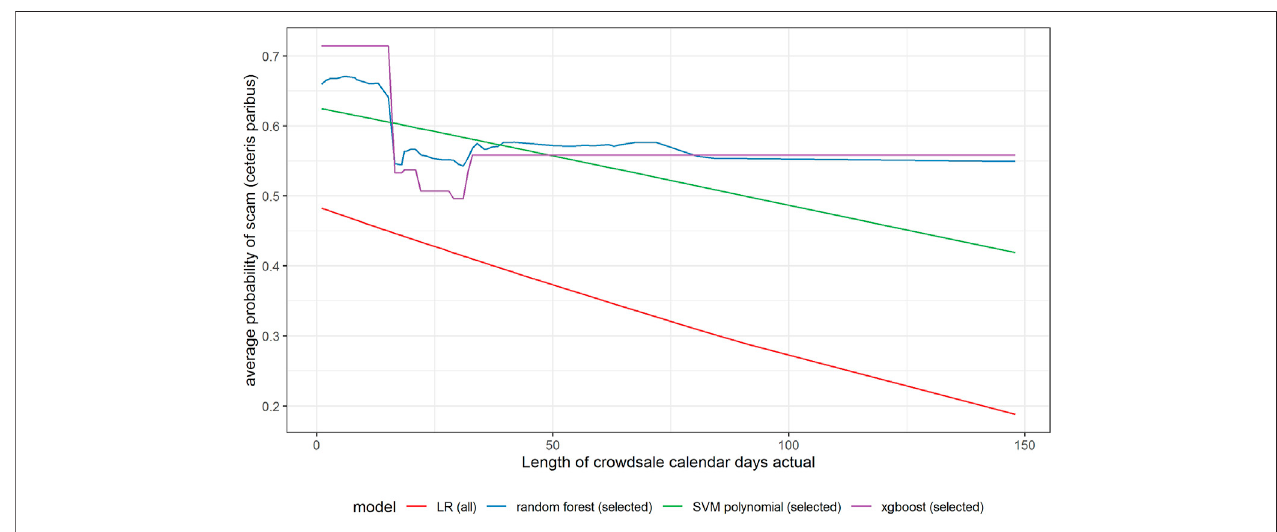
FIGURE 6 | Partial dependence plot for variable indicating actual crowdsale calendar days.